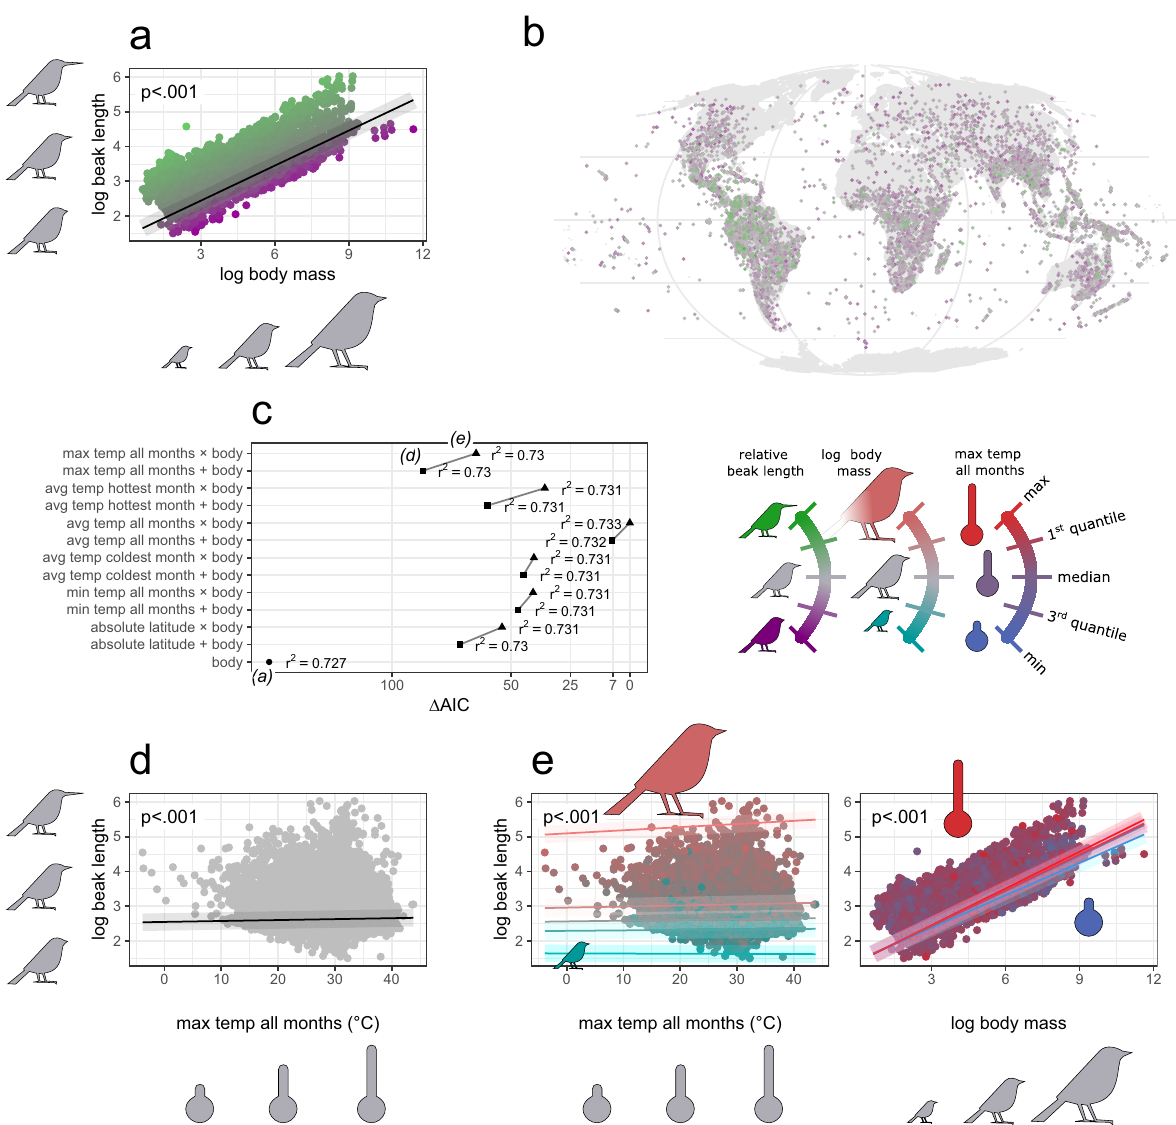
Fig. 2|GlobaltestofAllen ’ sruleonavianbeaklengthacross9962(99.7%)bird species. Thenullallometricmodel( a )usedtoscaletheabsolute(log-transformed) beak length with log body size, the residuals from which were used as the relative beak length. Distribution of relative beak length across species geographic ranges ( b ).Modelselectionprocedureforpredictinglogbeaklength( c ),involvingmodels with log body mass and either of six temperature measures within species geo- graphic ranges included as fi xed and interaction terms; AIC — Akaike Information Criterion, r 2 — coef fi cient of determination. An exemplar Allen ’ s model ( d ) showing increasing beak length with max temperature of all months, while controlling for